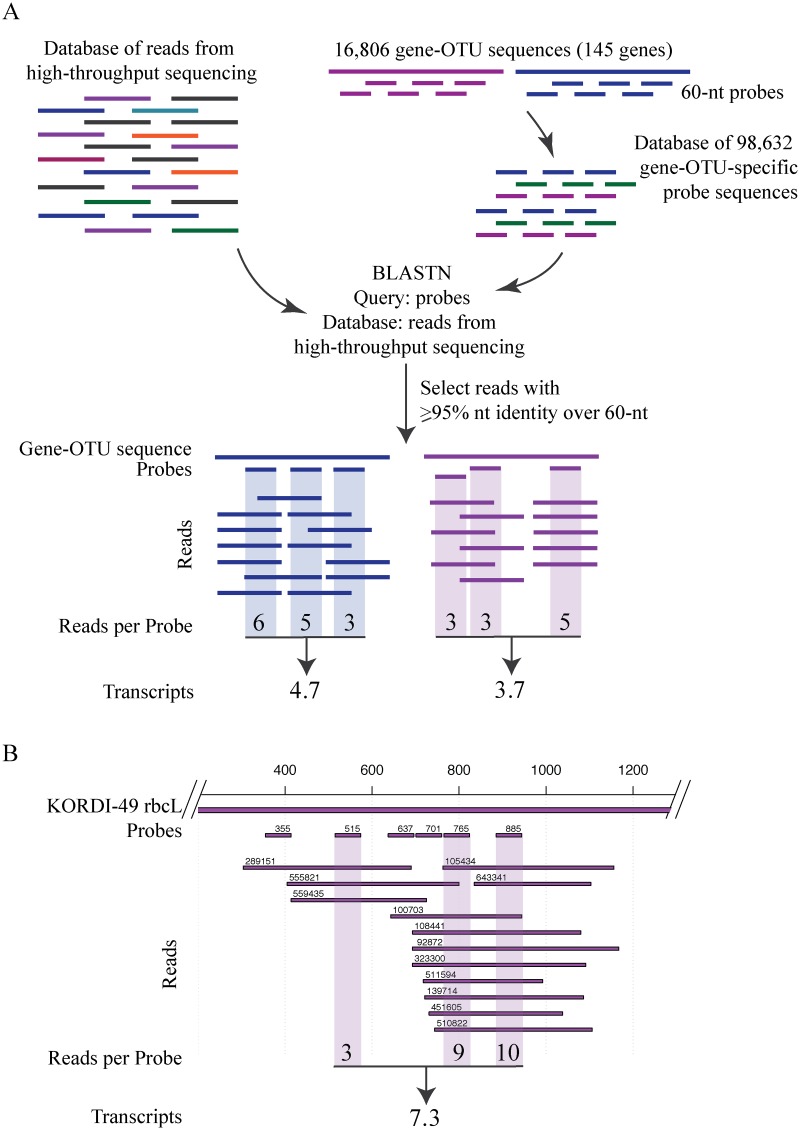
Principle of the MAGC approach for analysis of nucleotide sequences obtained from high-throughput sequencing.(A) Each of the16,806 gene-OTU has six highly specific probes, and all of the 98,632 probe sequences are used as queries in BLASTN searches against the database of nucleotide sequences obtained from environmental samples (metagenomes or metatranscriptomes). The transcript-OTU abundances are estimated as the averages of reads with ≥95% nucleotide identity (nt) across the entire length of each probe. (B) Distribution of probes specific for the Synechococcus KORDI-49 rbcL gene shown with reads identified with these probes in a California Current System diel study. Three probes (indicated with shaded area) for Synechococcus KORDI-49 rbcL had ≥95% nt sequence identity to reads from this sample. The read ID and probe start position are shown above each read and probe, respectively.